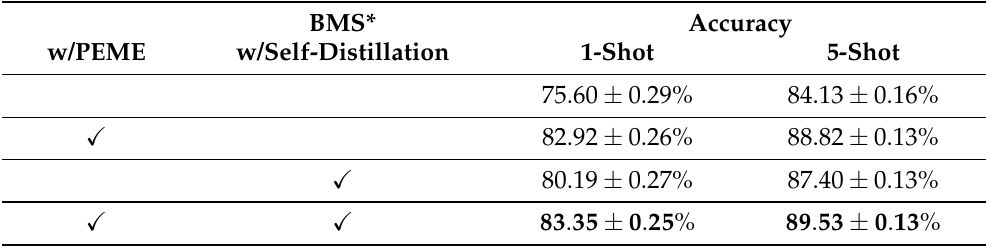
Table 4. Ablation study on our proposed PEME and BMS* with self-distillation on miniImageNet (backbone: WRN). Best results are in bold.